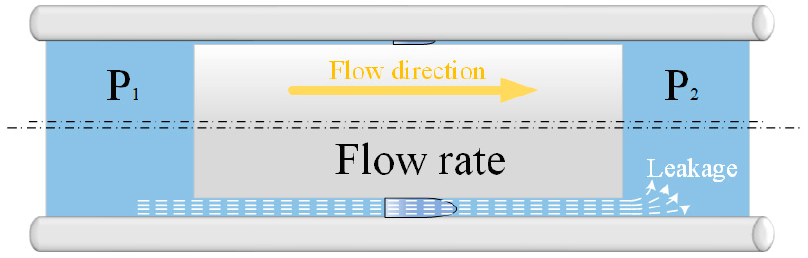
Figure 13. Leakage caused by internal clearance.